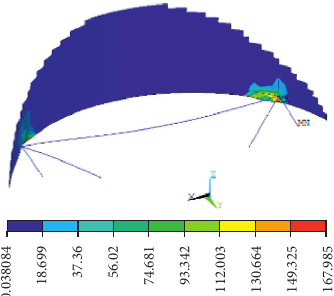
Figure 18: Stress distribution.